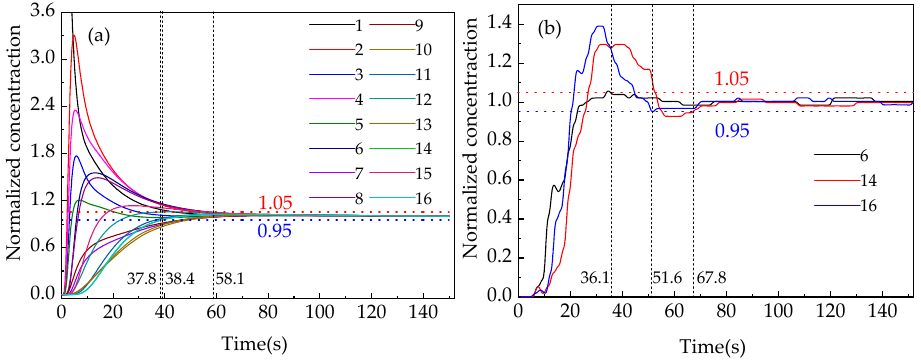
Figure 4. Variation in the tracer concentration at different monitoring points. ( a )Simulated curves and ( b ) experimental curves.